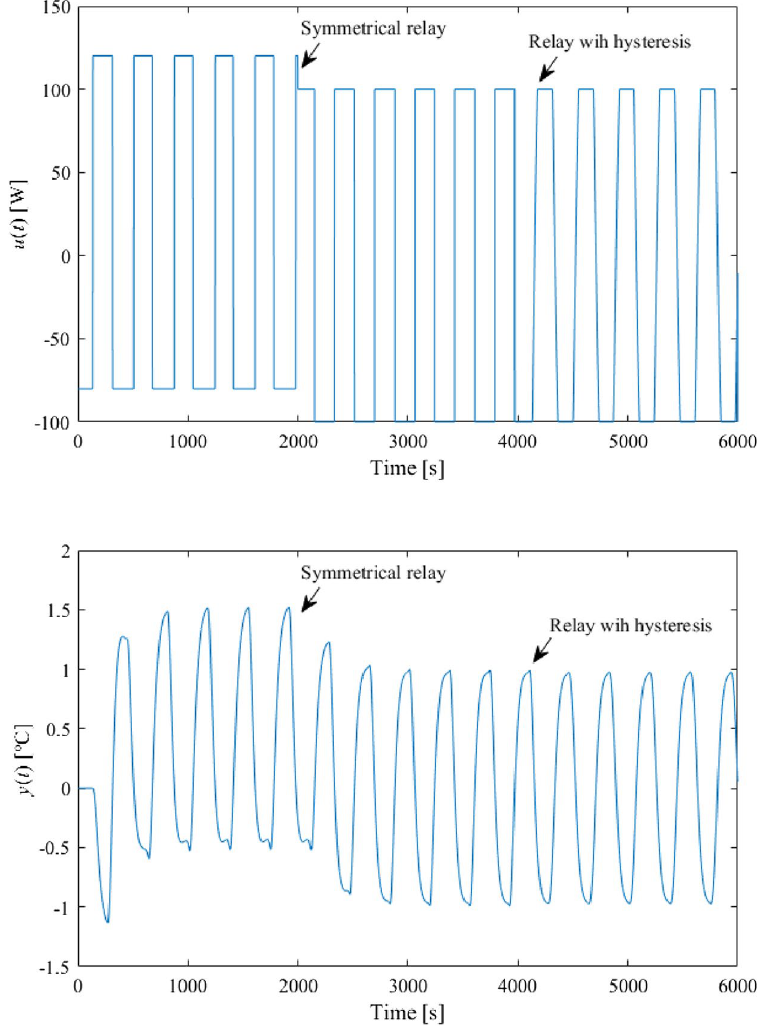
Figure 9. Relay experiment responses (without an artificial delay).